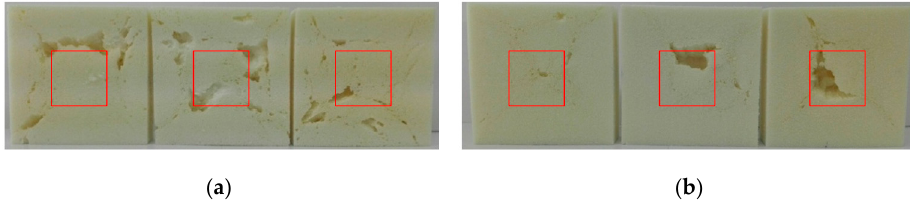
Figure 6. Photographs of PUR samples OPU_DEG_20 ( a ) and OPU_DEG_40 ( b ).